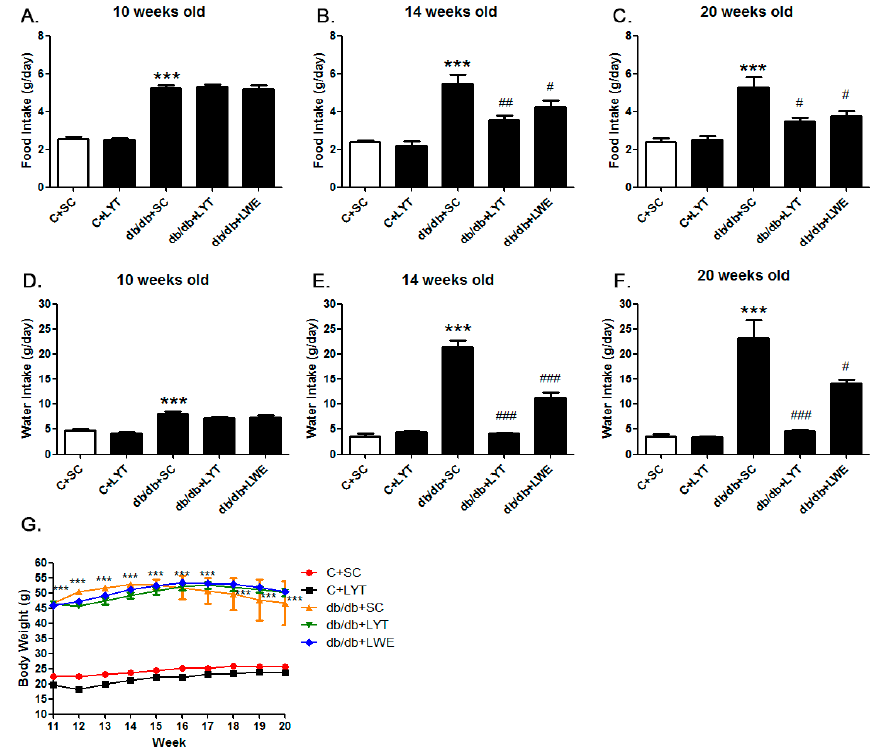
Figure 1. Food consumption ( A – C ) water intake ( D – F ) and body weight ( G ) of the control and db/db mice. C + SC: control mice fed the standard AIN93 diet (SC); C + LYT: control mice fed SC containing 5% of the large yellow tea powder (LYT); db/db + SC: db/db mice fed SC diet; db/db + LYT: db/db mice fed LYT diet; db/db + LWE: db/db mice fed LWE diet. Values are means ± SE ( n = 3). *** p < 0.001 when compared with the C + SC group; # p < 0.05; ## p < 0.01; ### p < 0.001 when